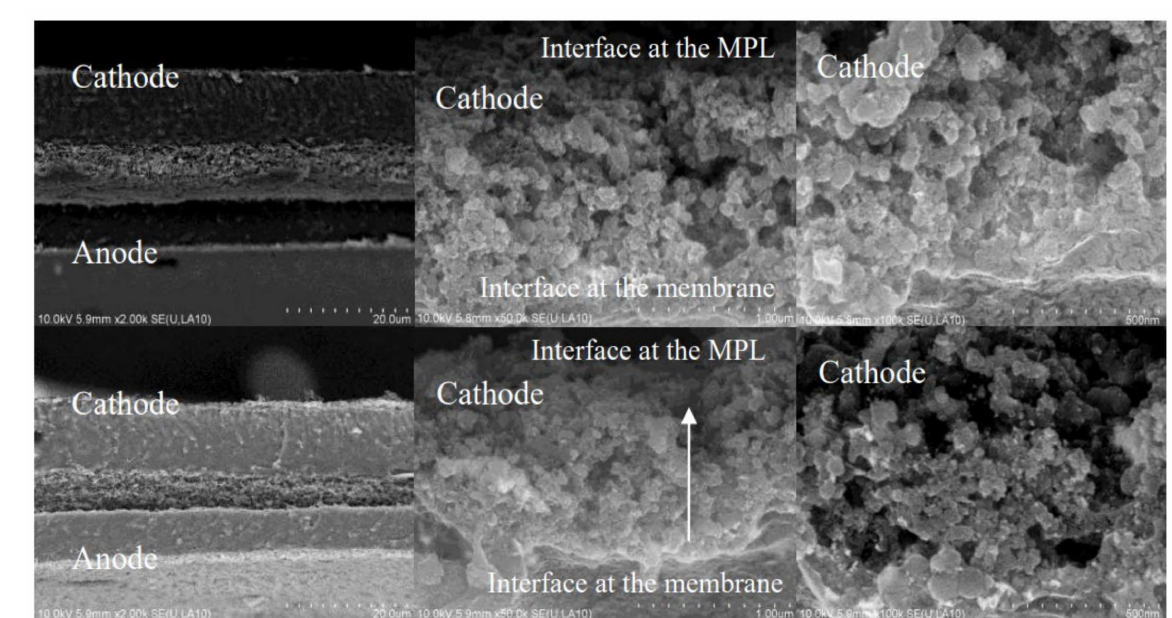
Figure 5. The SEM images of the cross section of MEA before (first row) and after (second row) 30 k cycles [72]. Copyright 2017 ECS